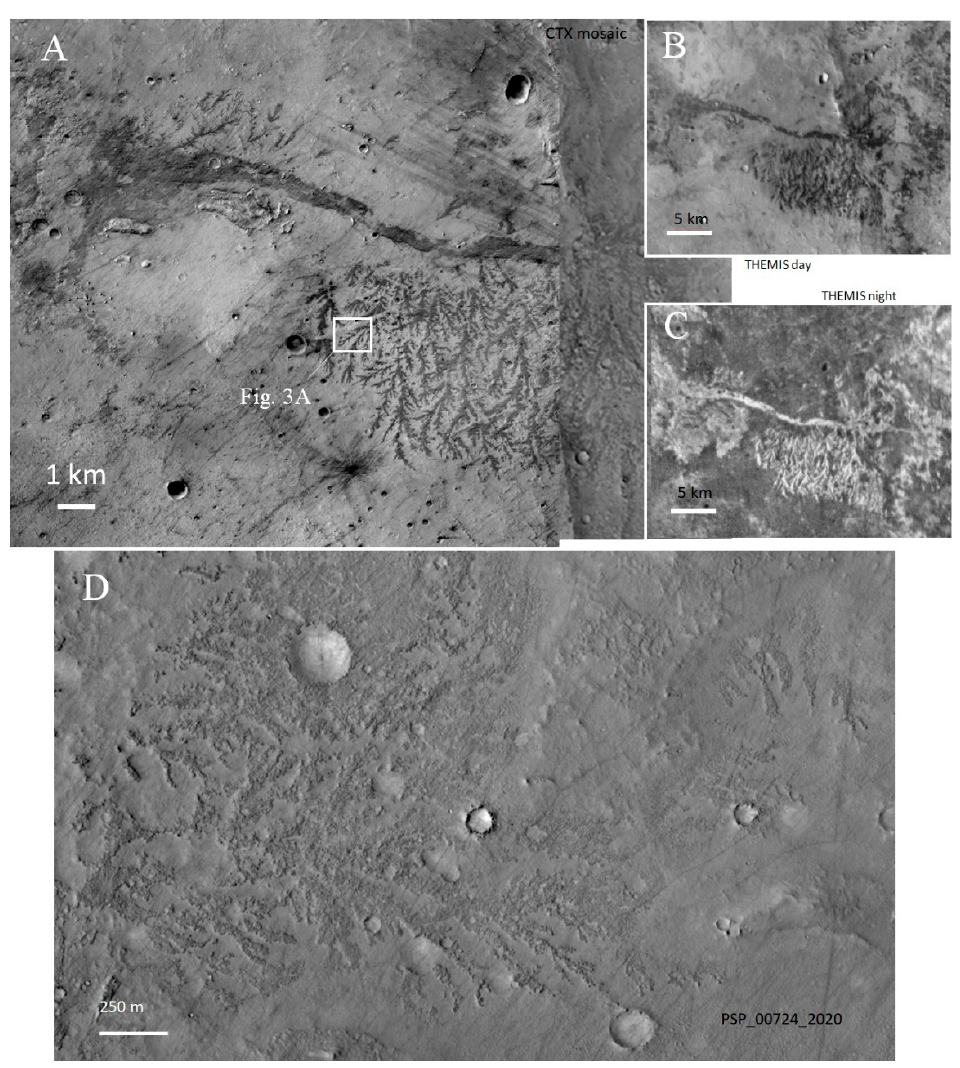
shaded rectangle. The dotted line is the northern part of the MOLA altimeter section shown in ( B ). ( E ) Highly schematic map of the main geomorphological features of Antoniadi. ( F ) Ideal strati- graphic scheme of the filling material inside central Antoniadi as deduced from examination of the sections of impact craters and faults. The section approximately corresponds to the vertical line drawn in E (crater ejecta not considered for simplicity).